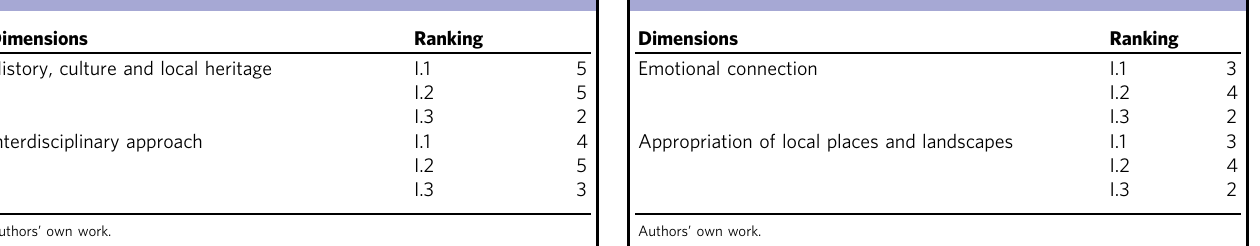
Table 11 Dimensions of the model (TB.3) and level of development for each